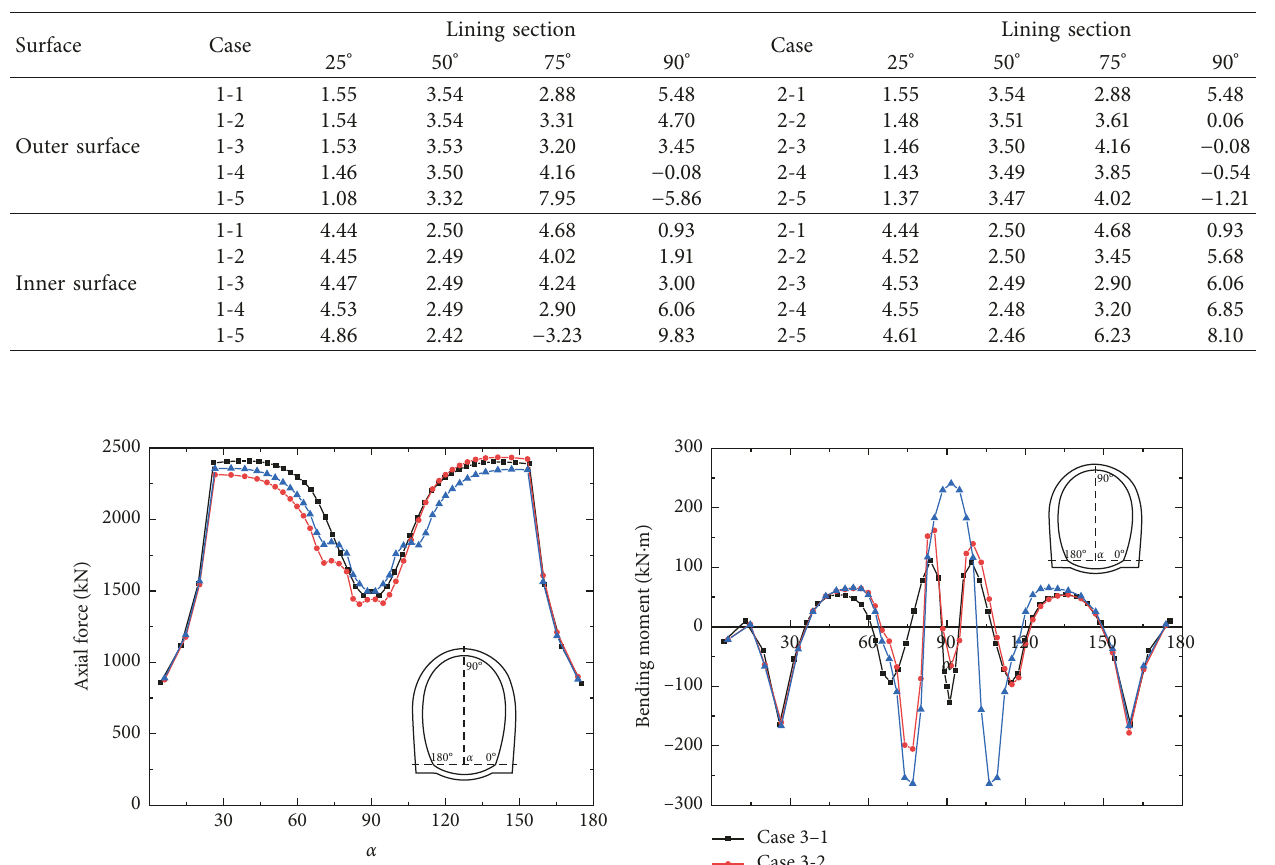
Figure 5: Bending moments of concrete lining. (a) Group 1. (b) Group 2. Table 3: Calculated stresses of selected lining sections in groups 1 and 2.